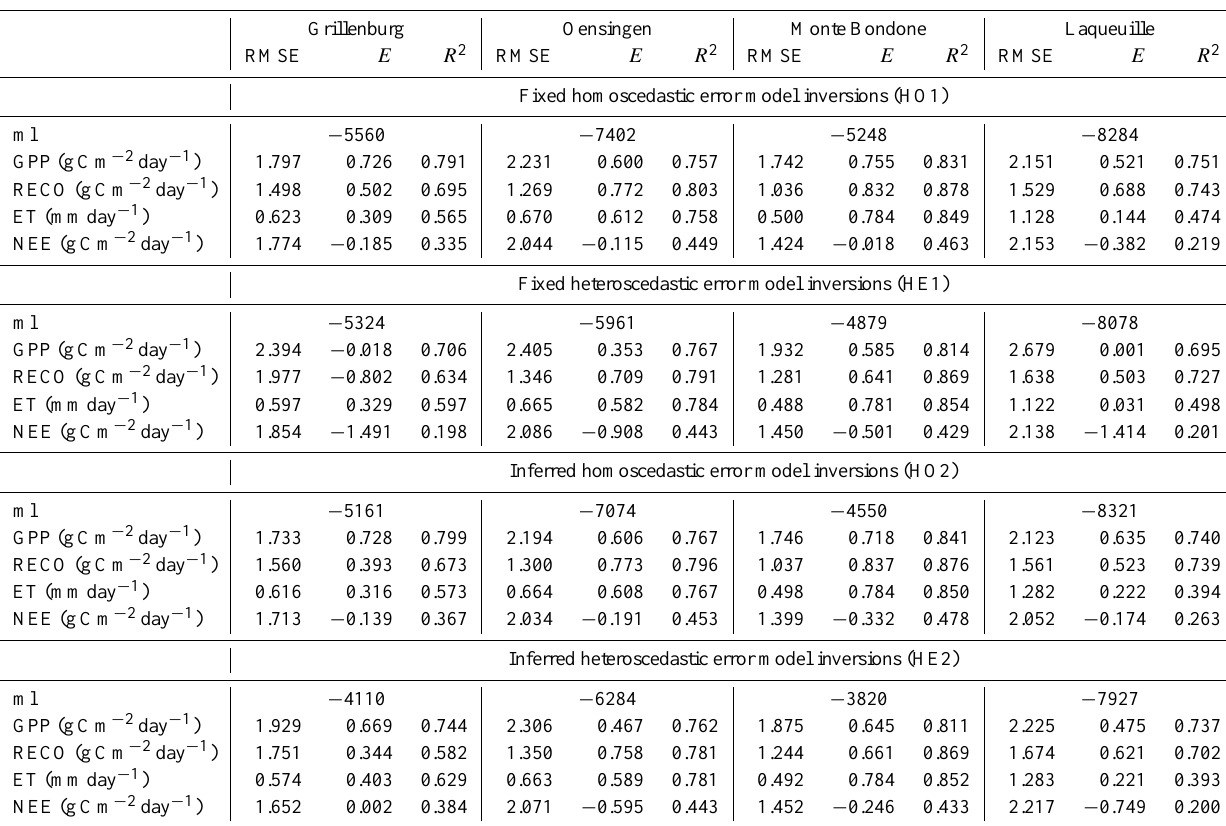
Table 4. Comparison between measured and modelled signals using most likely parameter values. The “ml” variable is the maximum value of the log-likelihood